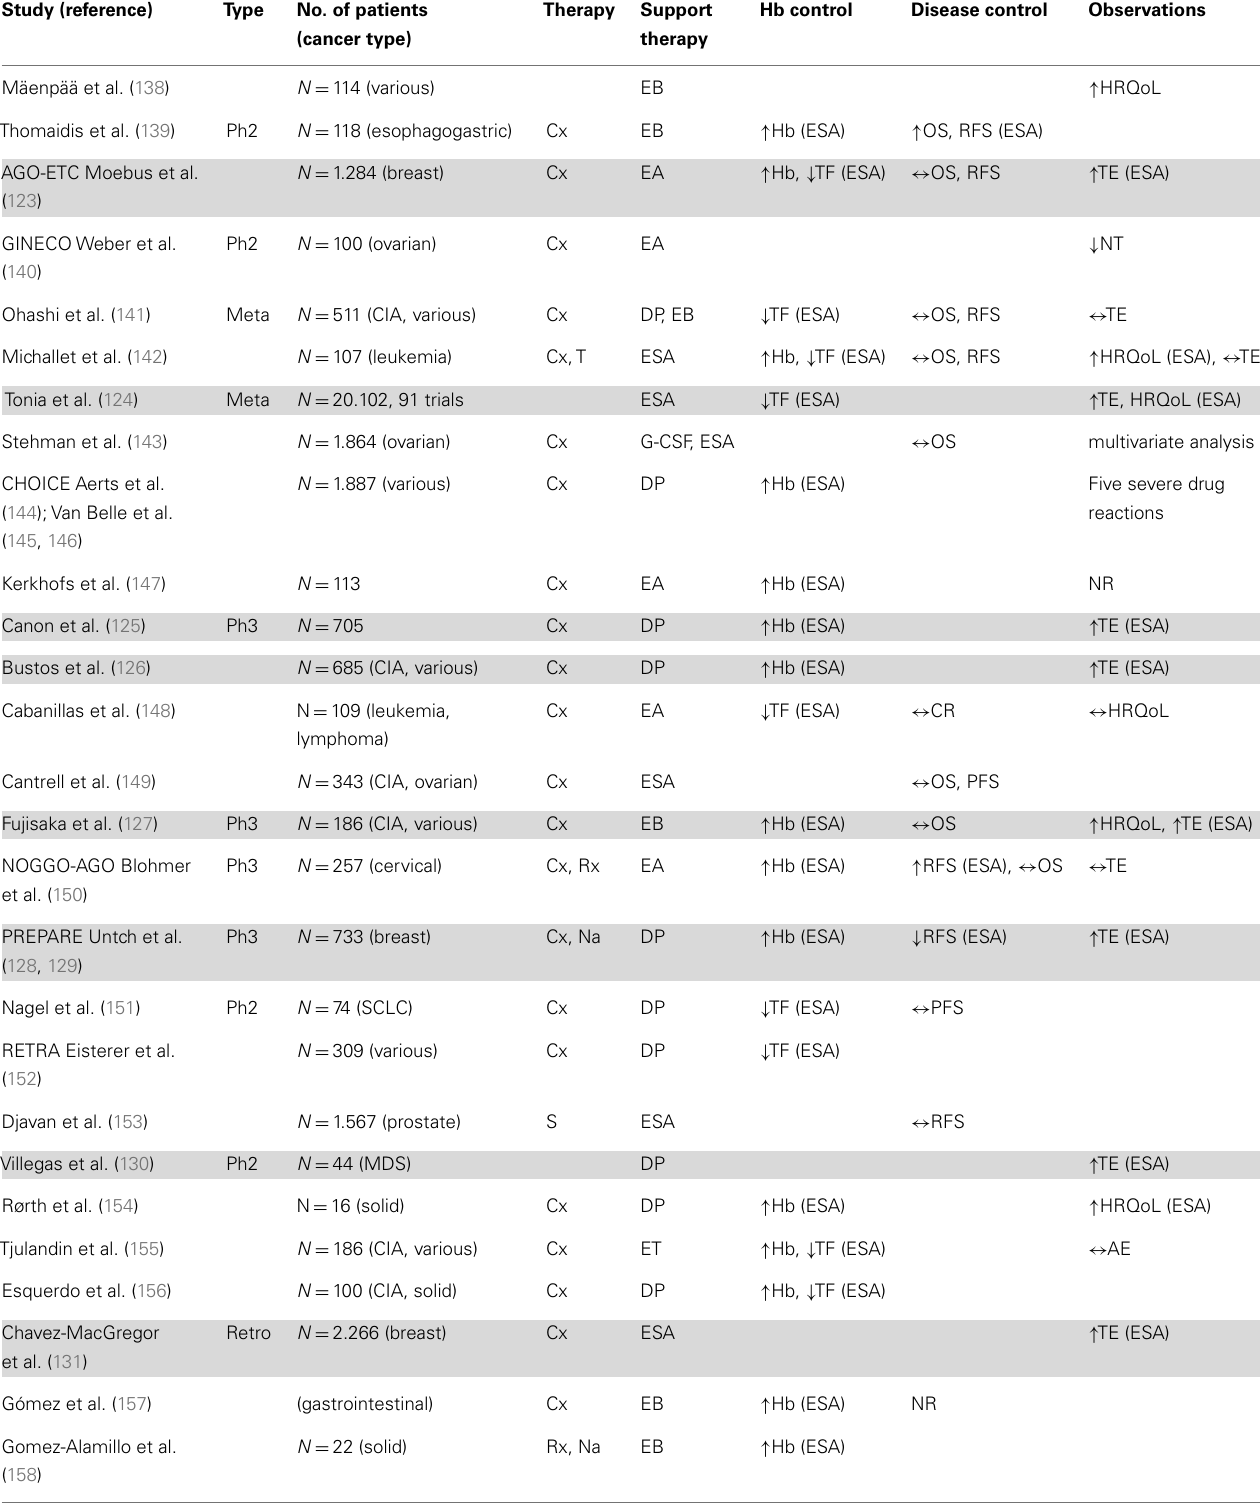
Table 1 | Clinical trials with reported effects of ESA in cancer patients performed between 2009 and 2014